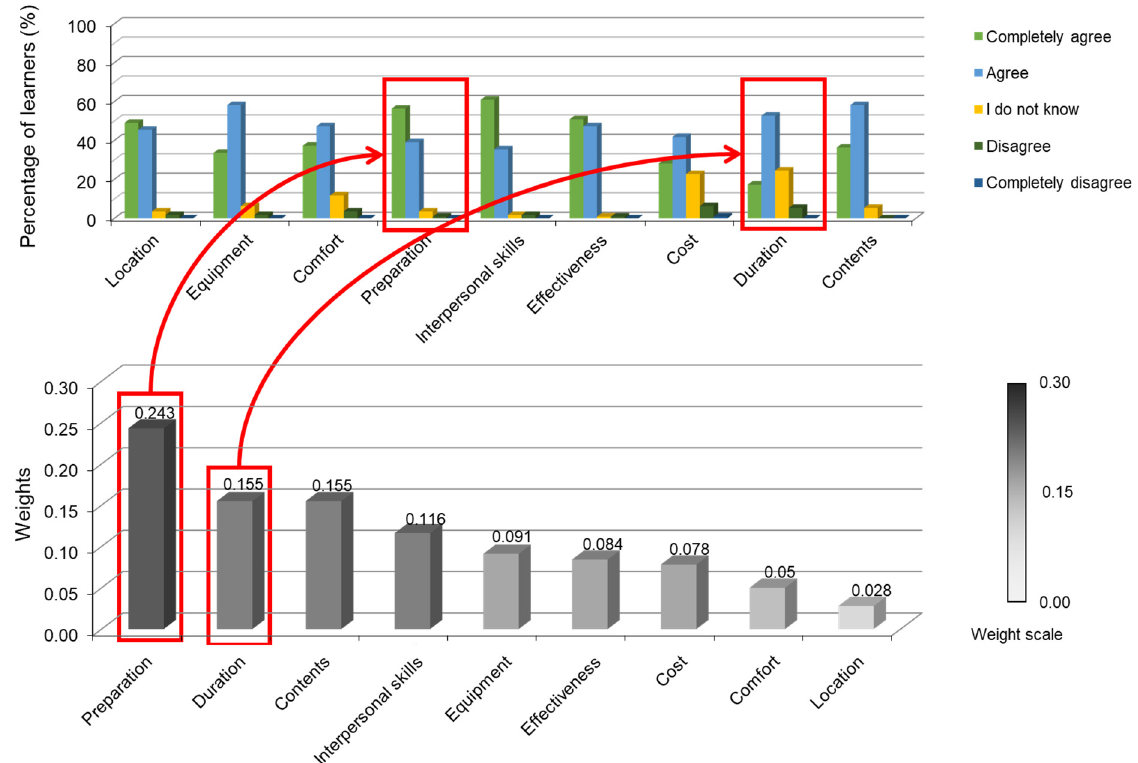
Figure 6. Comparison of the LS and AHP results.